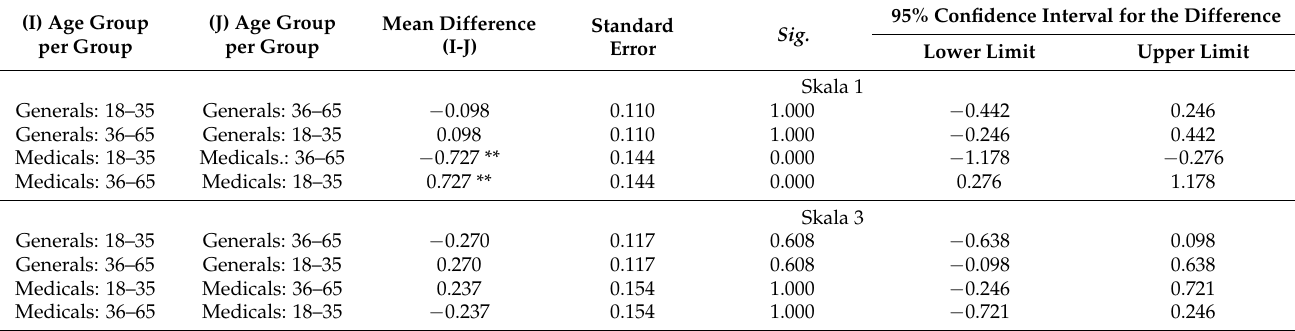
Table 6. Results of the pairwise comparisons according to the Bonferroni test of the two age groups within the general population and the medical professionals (post hoc of the MANCOVA) regarding the sum scores for the “stigmatization” and “normalization/glorification” scales of the